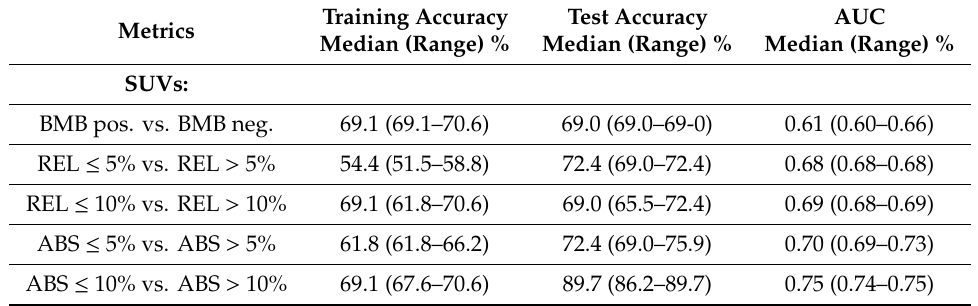
Table 2. Mean classification accuracies for radiomics only and radiomics + laboratory